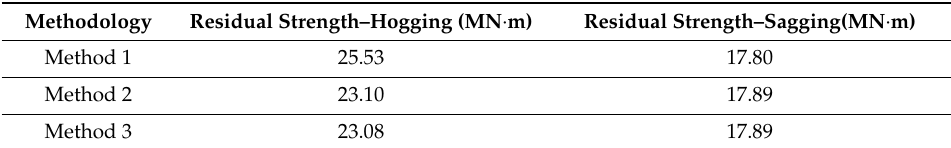
Table 6. Residual strength of CASE 2.